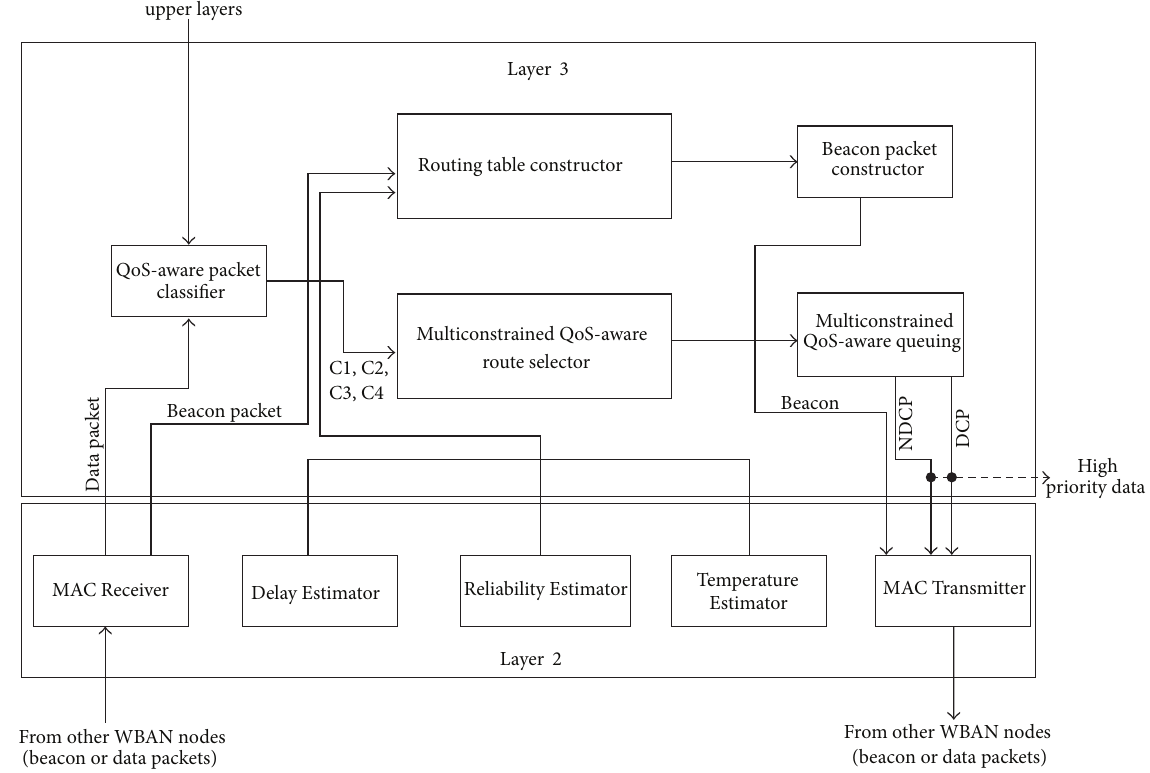
Figure 10: TMQoS routing architecture (redrawn from